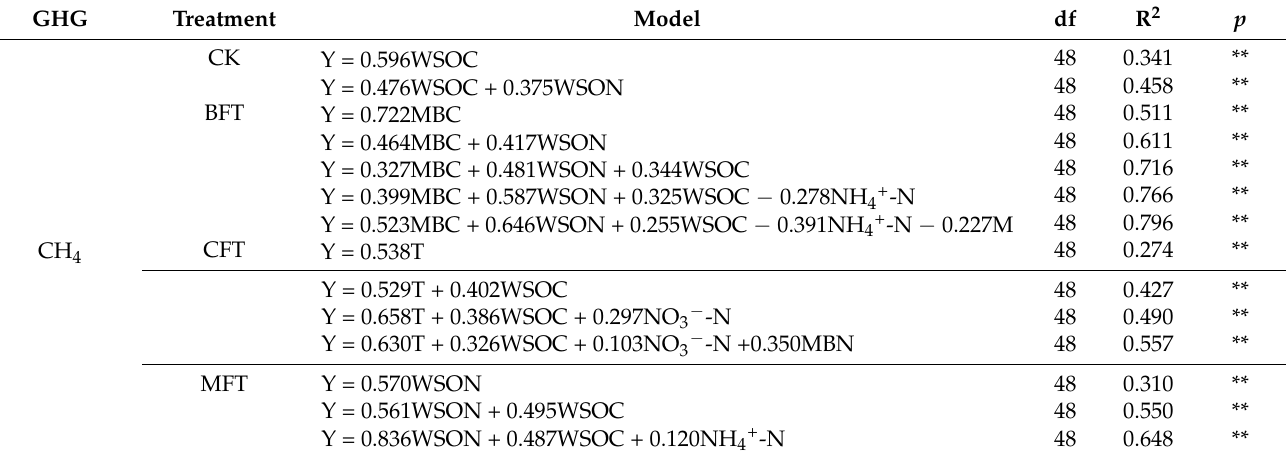
Table 3. Model for stepwise regression analysis between CH 4 flux ( µ g m − 2 h − 1 ) and soil temperature (T, ◦ C), soil moisture (M, g kg − 1 ), microbial biomass C (MBC, mg kg − 1 ), water-soluble organic C (WSOC, mg kg − 1 ), microbial biomass N (MBN, mg kg − 1 ), water-soluble organic N (WSON, mg kg − 1 ), NO 3 − -N, and NH 4+ -N under CK, BFT, CFT, and MFF treatments. (The coefficient in the model